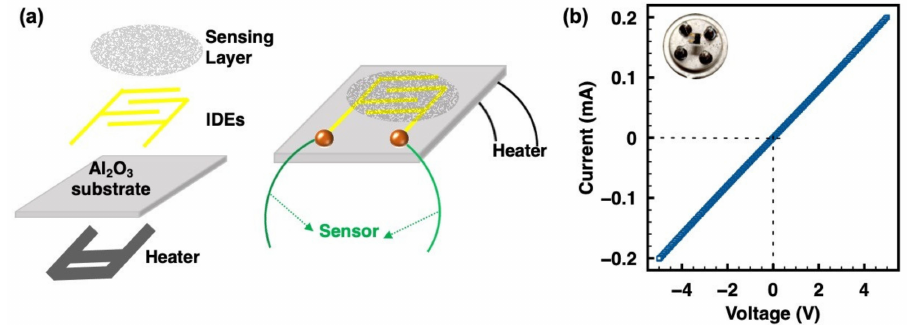
Figure 2. ( a ) Schematic diagram of the sensor device integrating with a microheater platform. ( b ) Linear I–V plot of the sensor device demonstrating Ohmic contact between the ZIF-8/CNT layer and IDEs; the inset is the optical image of the sensor device, showing the sensing layer on the